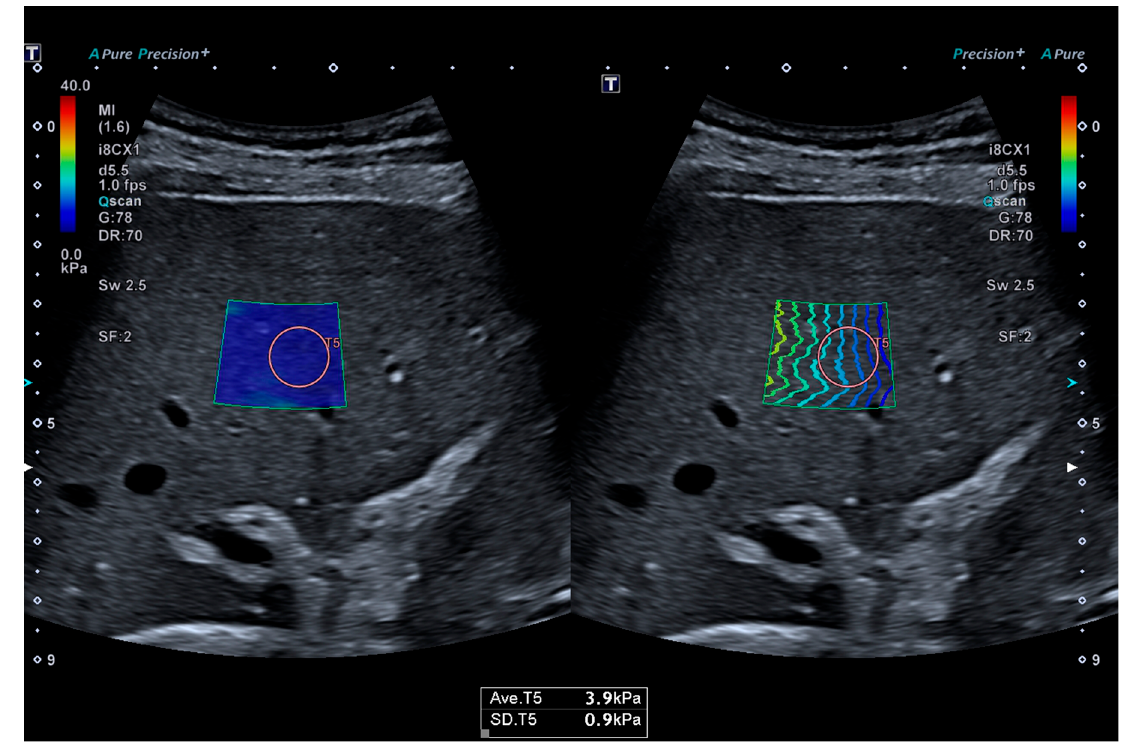
Figure 1. The propagation of the shear waves in the liver tissue is visualized as color-coded ( left side ) and in parallel lines ( right side ). The measured liver stiffness is 3.9 kPa, indicating the absence of significant fibrosis.